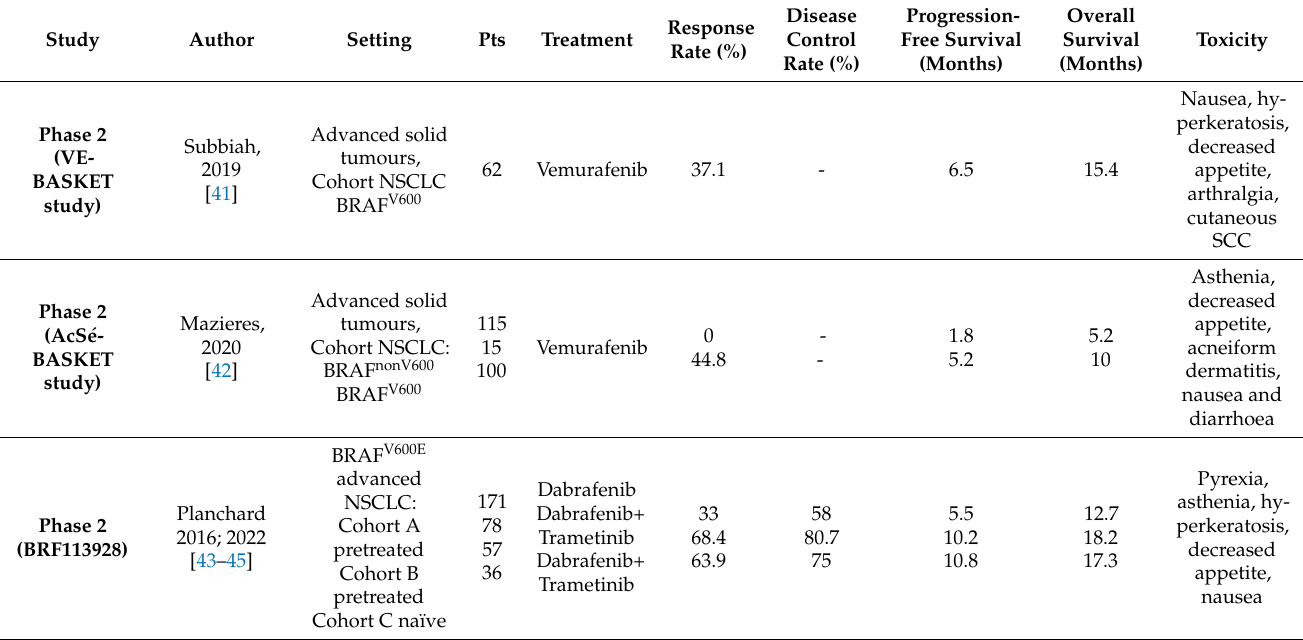
Table 1. Clinical trials with BRAF and MEK inhibitors in